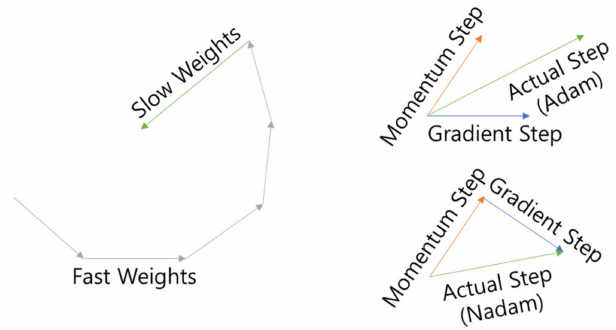
Figure 11. Update method of Lookahaed, Adam, and Nadam.